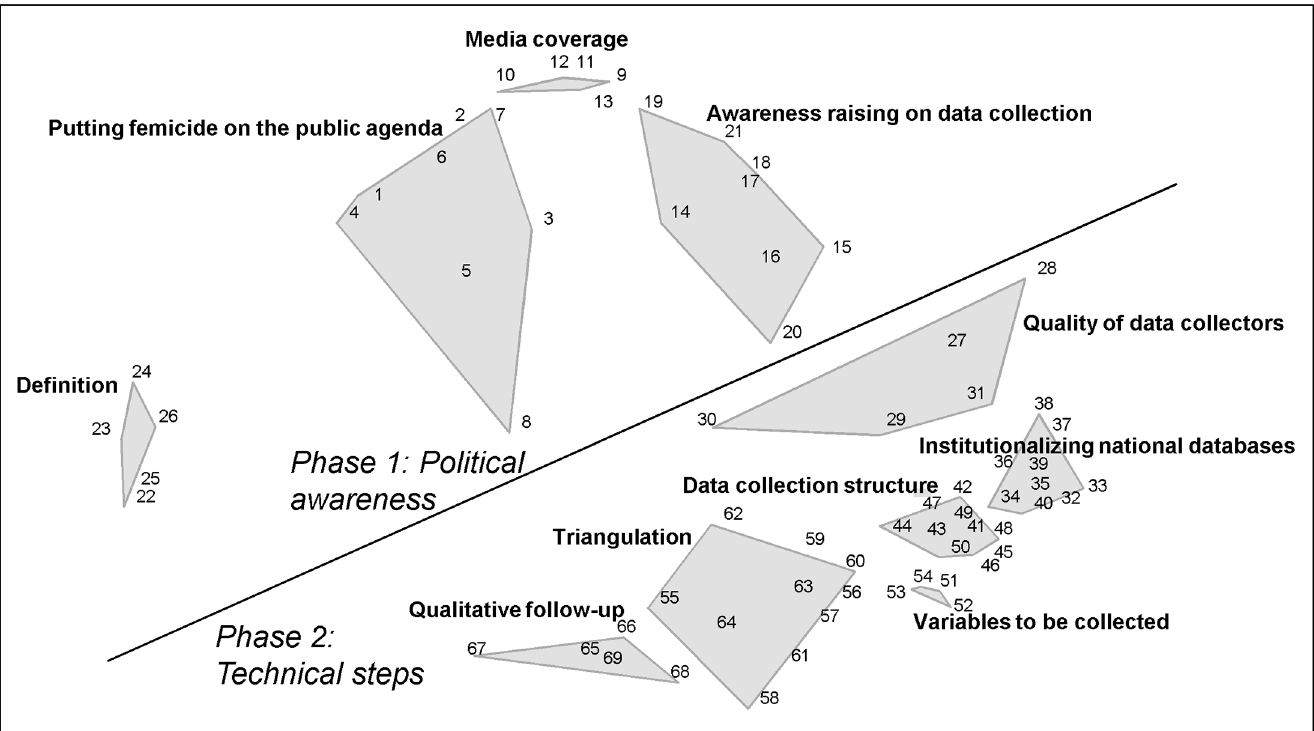
Fig 1. Clusters of actions to promote improvement of data collection systems on femicide across Europe. Cluster map based on experts ’ thematic grouping of action strategies.